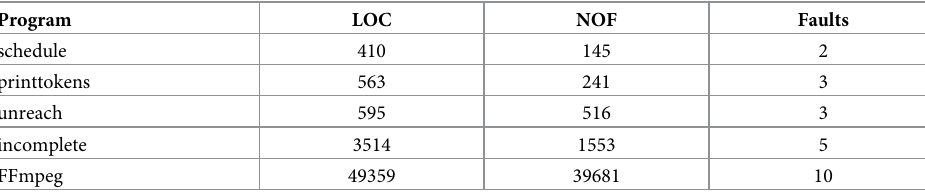
Table 3. Subject programs detail and faults